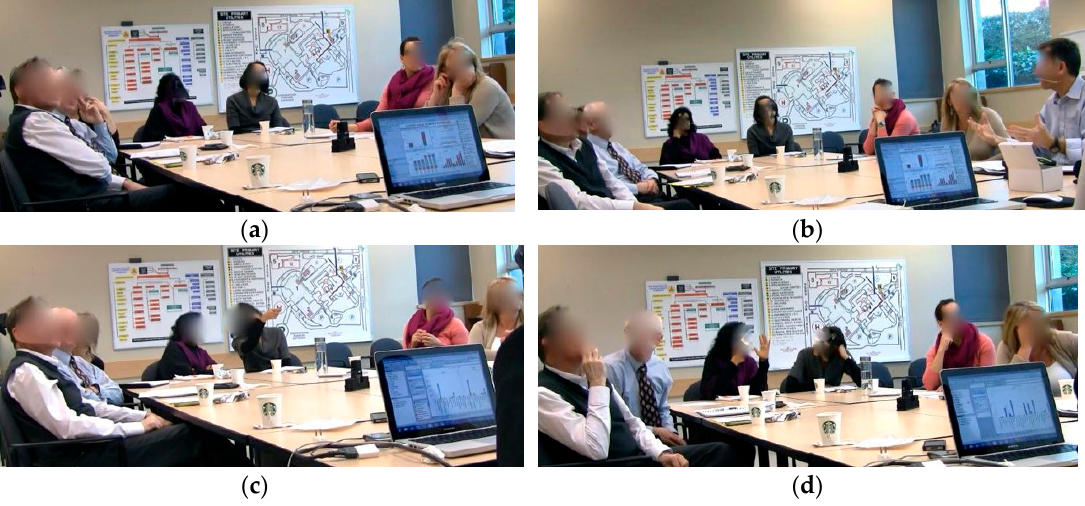
Figure 5. ( a ) All to Artefact (SMEs- i AID); ( b ) All to One (SMEs-SME); ( c ) Pairs, rest to